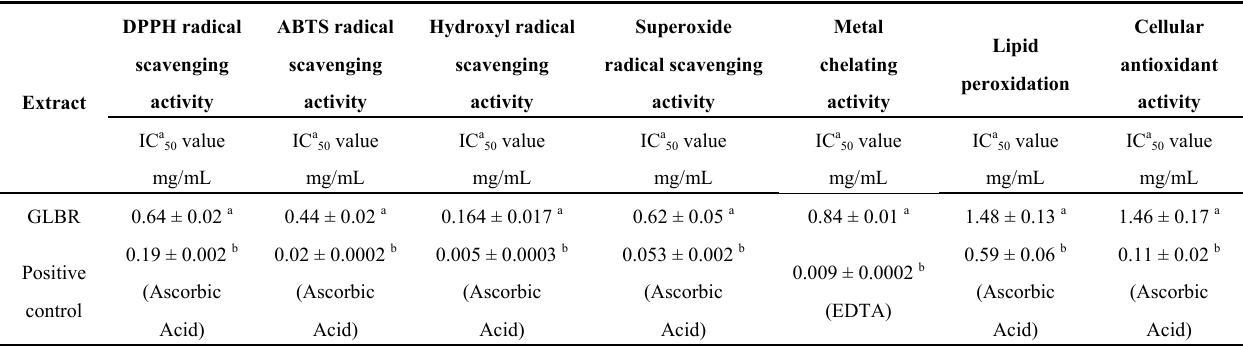
Table 2. DPPH, ABTS, nitrite, reducing power and metal chelating activities of GLBR